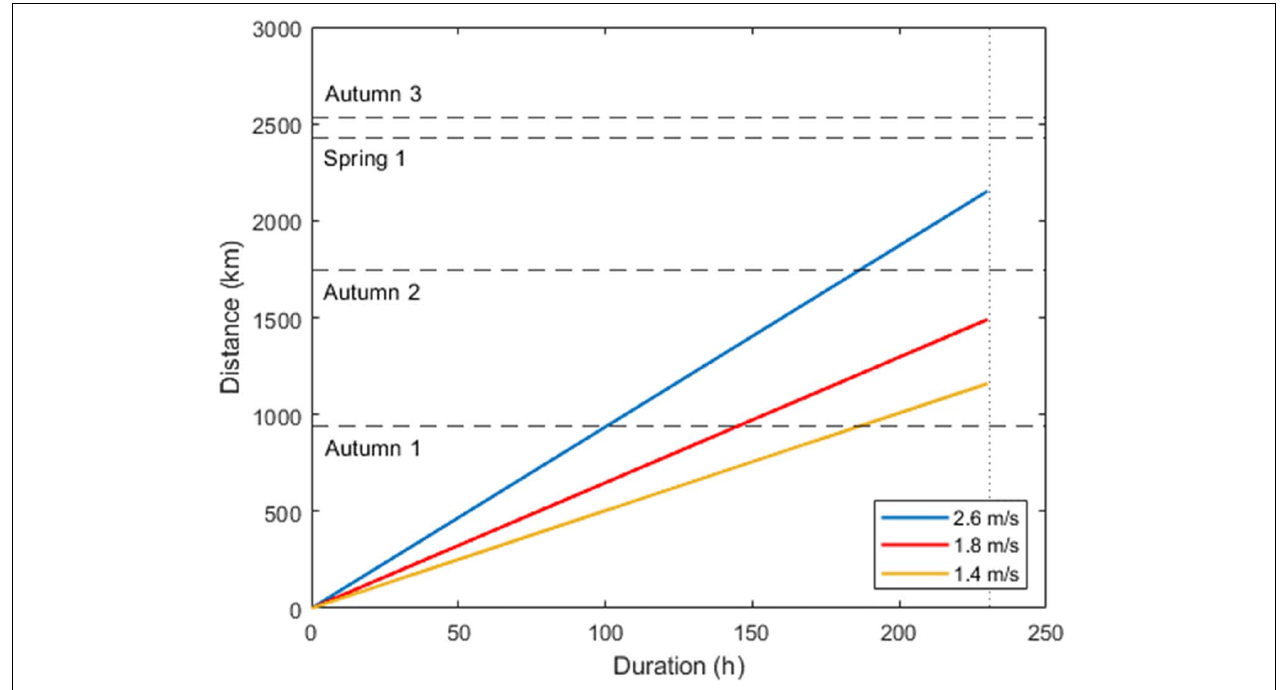
FIGURE 2 | Estimated flight distances assuming a combination of 20% active flight and 80% gliding flight. Colored lines reflect different self-powered speeds, and the figure assumes no contribution of wind. Self-powered speeds are based on the assumption of 5 m/s for active flight (20% of the time) and three differing gliding speeds (80% of the time): 0.5, 1, and 2 m/s. The dotted vertical line denotes the estimated maximum flight duration (230.45 h). The dashed horizontal lines reflect hypothetical flight distances during autumn and spring migration, based on the shortest distance from the wind trajectory departure sites to land across the Indian Ocean (Autumn 1: 938 km; Autumn 2: 1,744 km; Autumn 3: 2,536 km; and Spring 1: 2,430 km, see Table 2